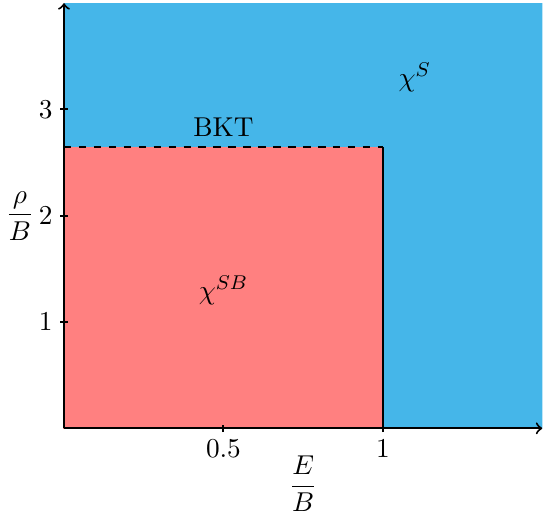
Figure 2 . Phase diagram for the D3/D5 system: the blue region covers the chirally symmetric phase, (cid:31) S , and the red region the spontaneously broken phase, (cid:31) SB